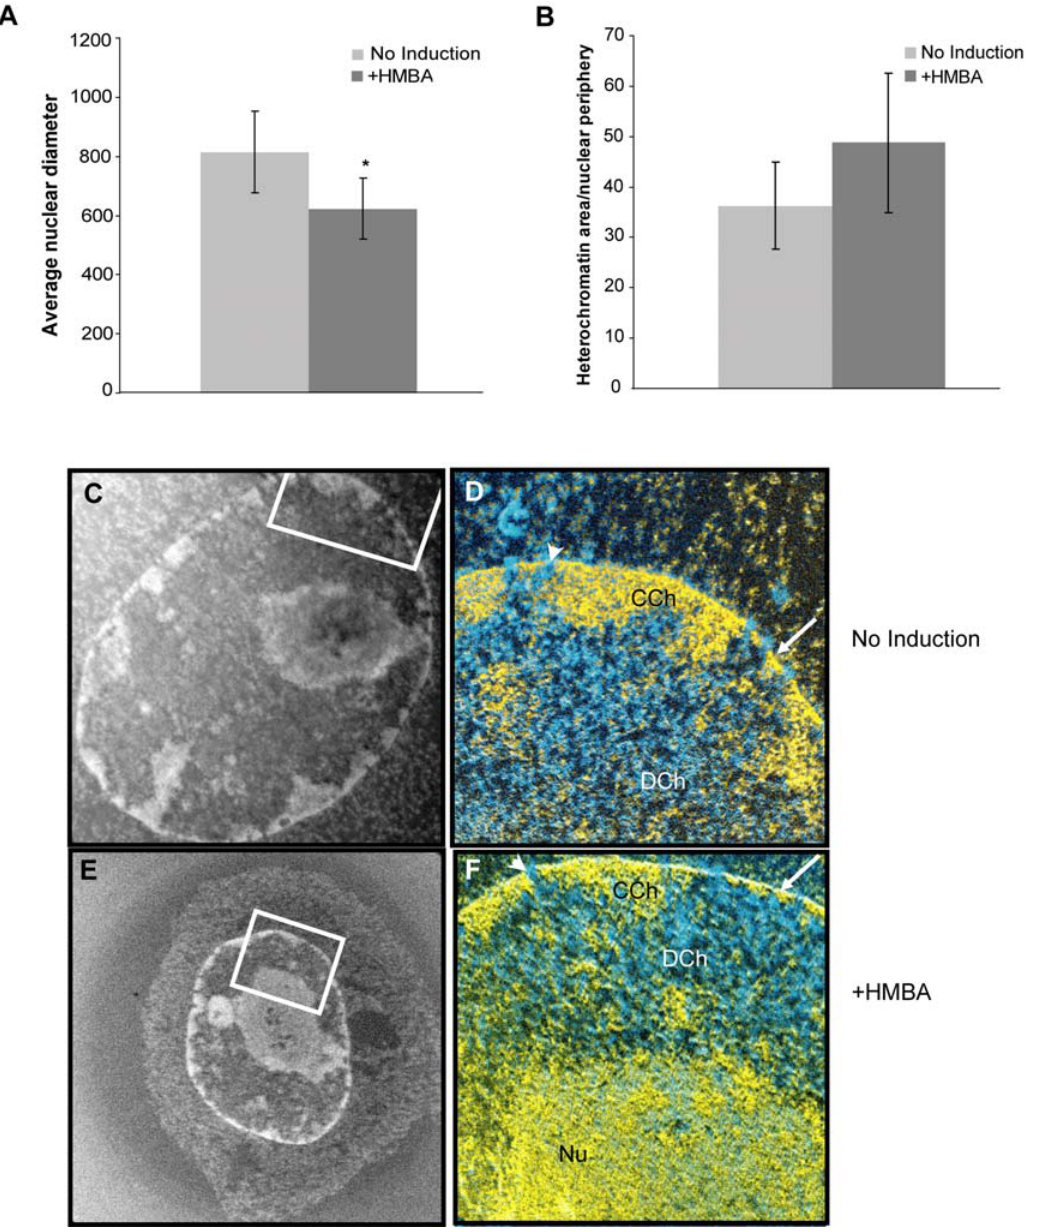
Figure 8. Nuclear organization of ultrastructural heterochromatin in MEL cells during HMBA induction. Electron Spectroscopic Imaging (ESI) analysis of undifferentiated and three-day differentiated MEL cells. (A) The average diameter of undifferentiated MEL cells changes upon HMBA differentiation. The diameters of sectioned cells were measured as described in the methods section. (B) The change in size is correlated to a small and statistically insignificant change in peripheral heterochromatin distribution after differentiation. Low magnification phosphorus enhanced mass images of a large undifferentiated nucleus (C) and a small differentiated (E) nucleus. Higher-resolution element specific ratio maps were acquired of regions of interest indicated by white boxes. Phosphorus element specific ratio maps were pseudo-coloured yellow and overlaid onto phosphorus subtracted nitrogen maps pseudo-coloured cyan. Phosphorus containing chromatin appears yellow and protein-rich regions are blue. An example of condensed chromatin regions are indicated (CCh) in both the undifferentiated (D) and differentiated (F) cells as is a decondensed region (DCh), the nucleolus is demarked by Nu and nuclear pores with a bold arrowhead and thinly represented condensed chromatin at the envelope with a white arrow.